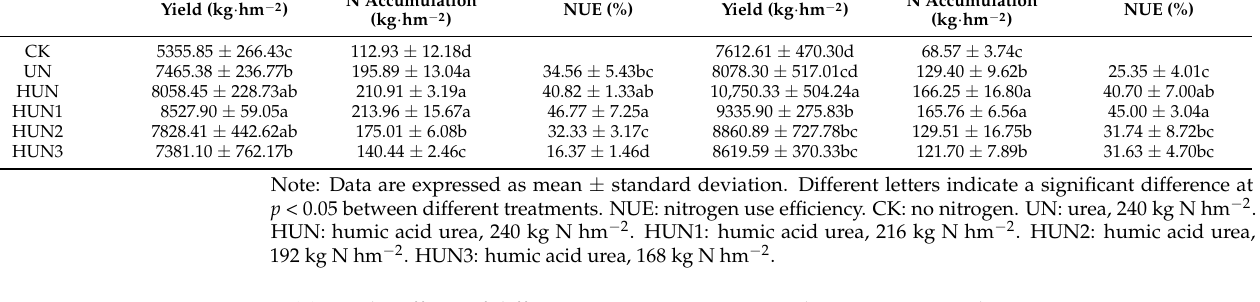
Table 3. The effects of different treatments on TEP and NEP in maize-wheat